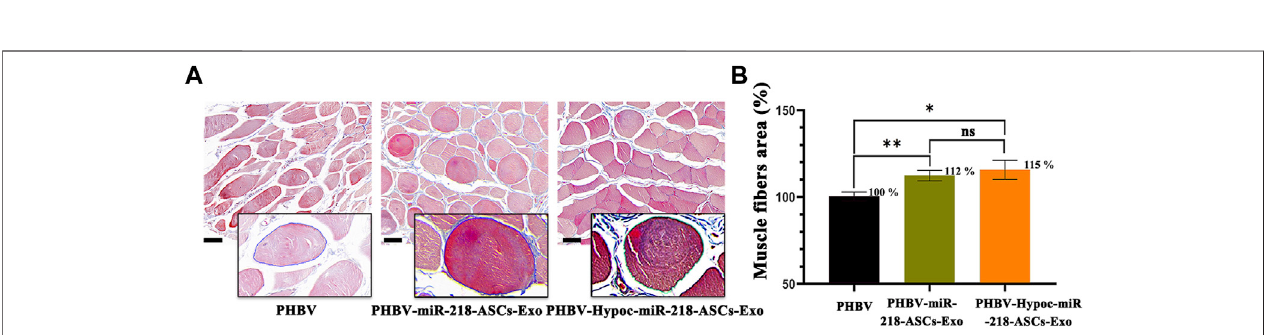
FIGURE13| Massontrichrome stainingofthreegastrocnemiusmusclesgroups. (A) Imageofmassontrichromestainingofthree groups(scalebars =40 μ m). (B) Muscles fi bers area was calculated.